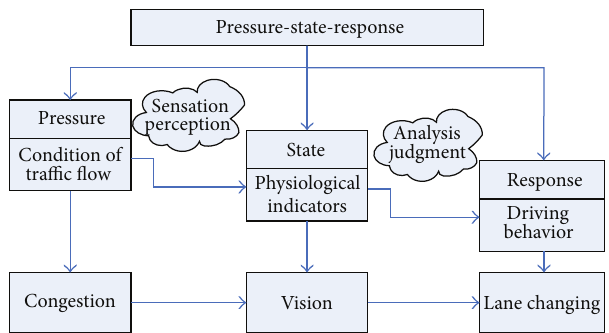
Figure 1: Model of driver’s